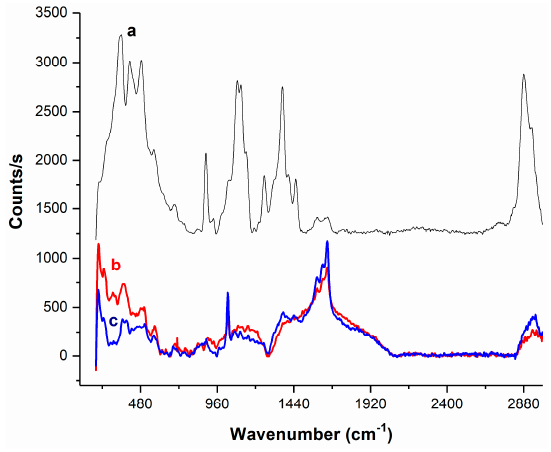
Figure 5. Raman spectra of the chitosan powder ( a ); the chitosan macrospheres ( b ); and the enzyme-chitosan macrospheres ( c ).